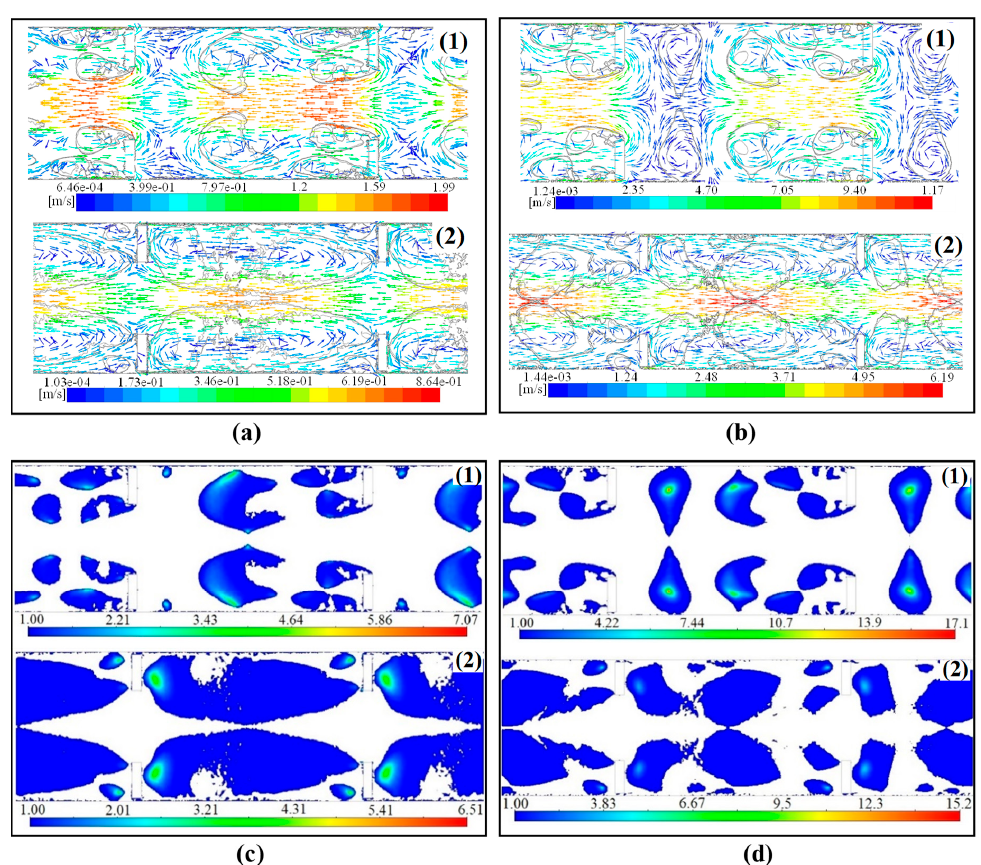
Figure 13. Oscillations phases during an oscillation cycle. Processes 2020 , 8 , x FOR PEER REVIEW 25 of 35